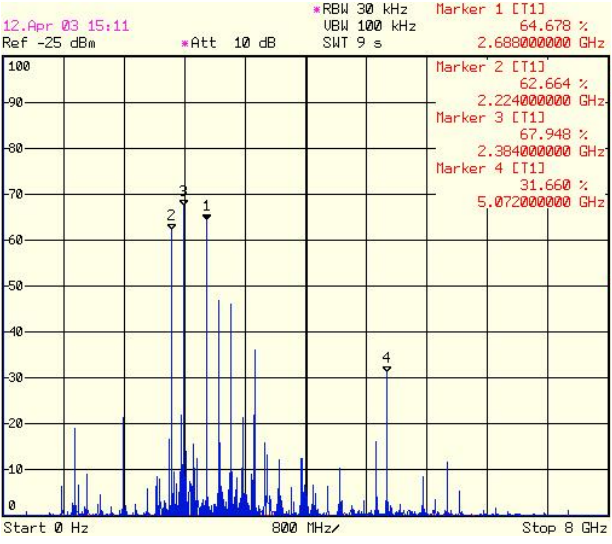
FIG. 6. (Color) Wake field spectrum measured in the PEP-II tunnel in a multibunch regime.